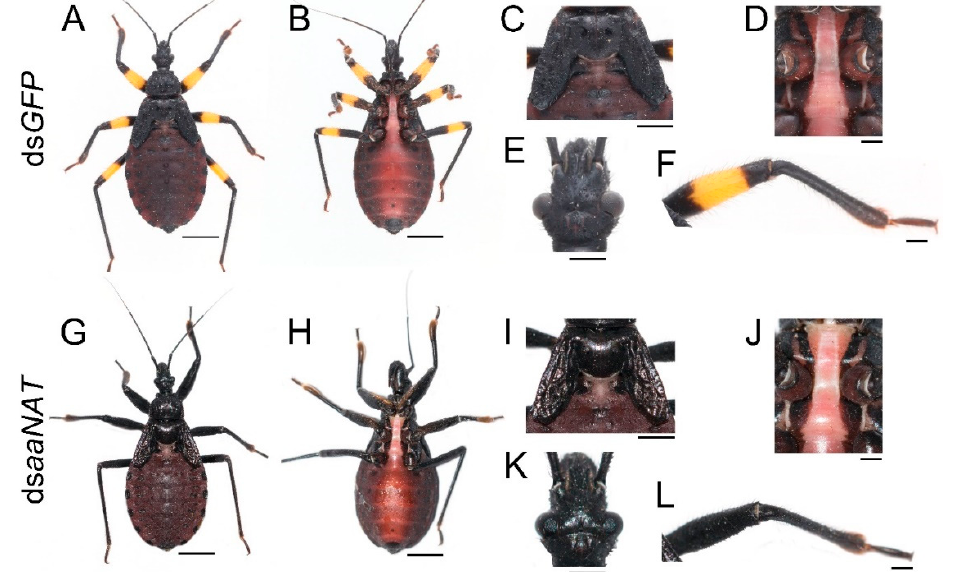
Figure 4. Functions of aaNAT in P. biguttatus nymphs. Nymphs treated with ds GFP showed normal pigmentation patterns of the dorsal ( A ) and ventral side ( B ), including the wing discs ( C ), the sternum ( D ), the head ( E ), and the leg ( F ). Nymphs treated with ds aaNAT showed darker pigmentation patterns than those treated with ds GFP ( G – I , K ), the yellow annulation of the leg turned black ( L ), while the color of sternum was not apparently changed ( J ). Scale bars, 5 mm ( A , B , G , H ), 2.5 mm ( C , I ), 1.25 mm ( E , K ), 1 mm ( D , F , J , L ).